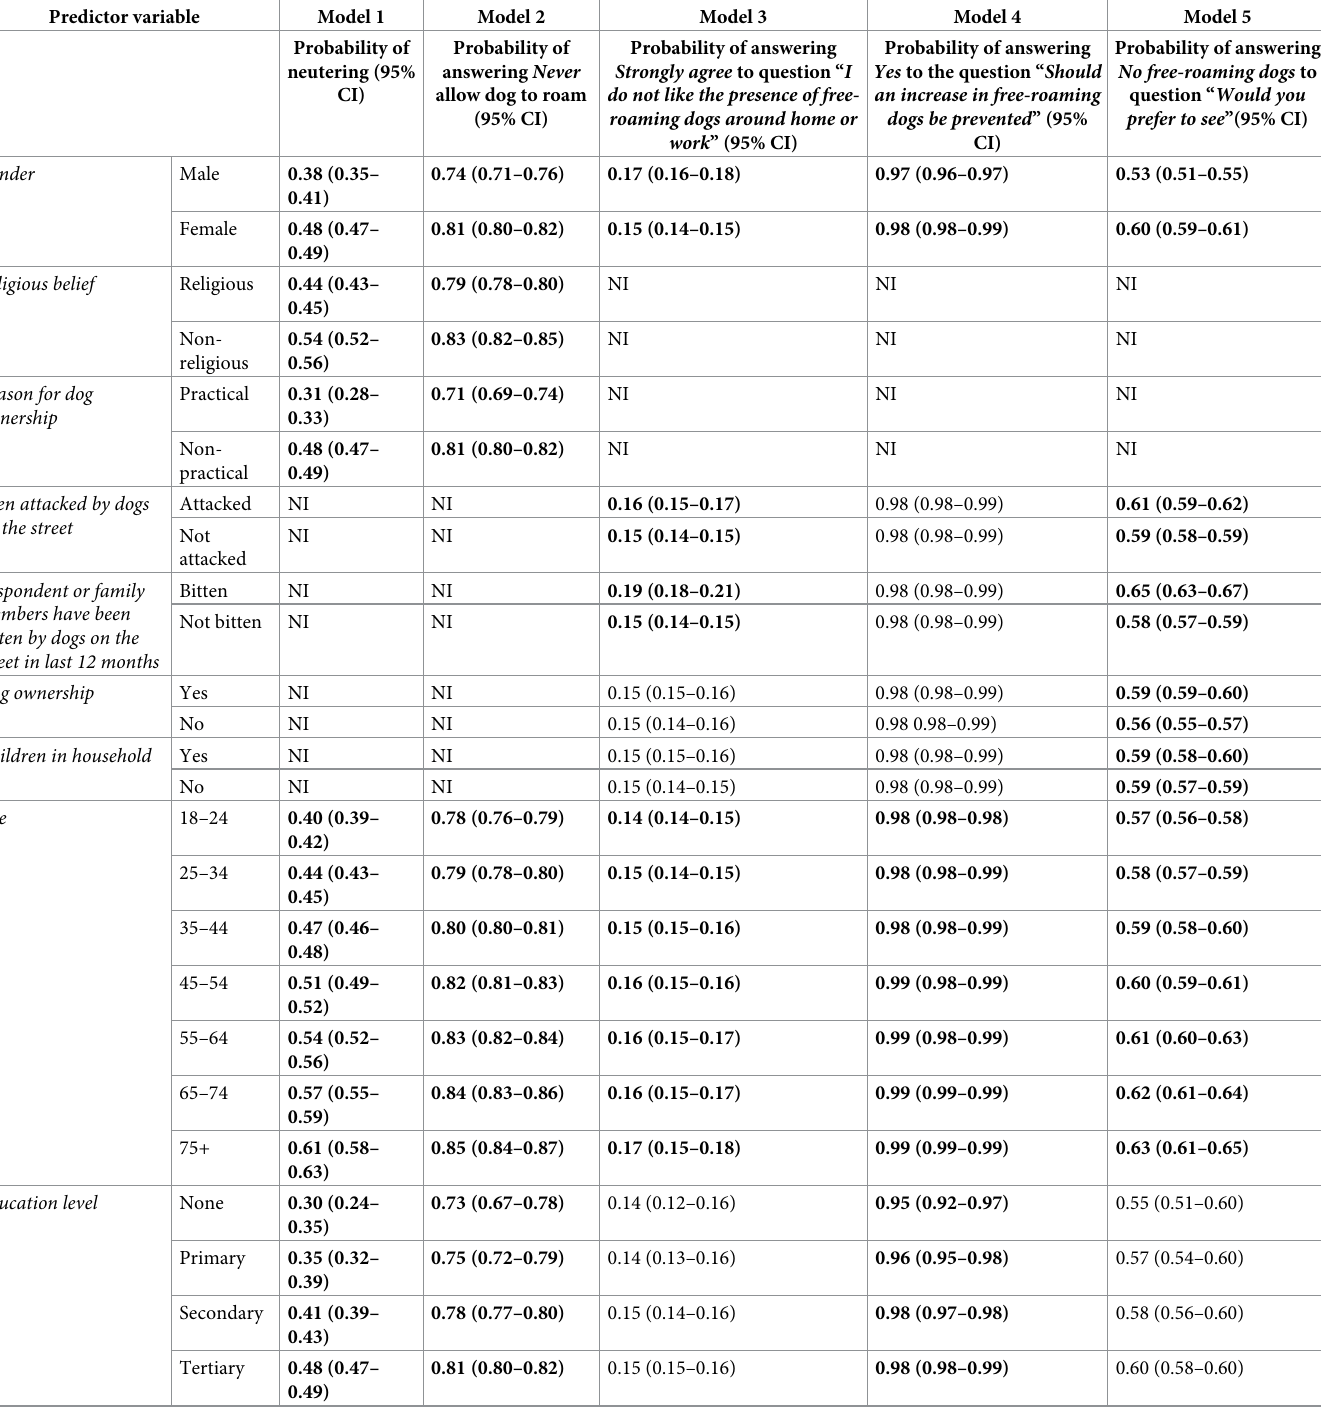
Table 2. Associations between predictor and outcome variables on the probability